Question: Looking at the figure, what chart type is it?
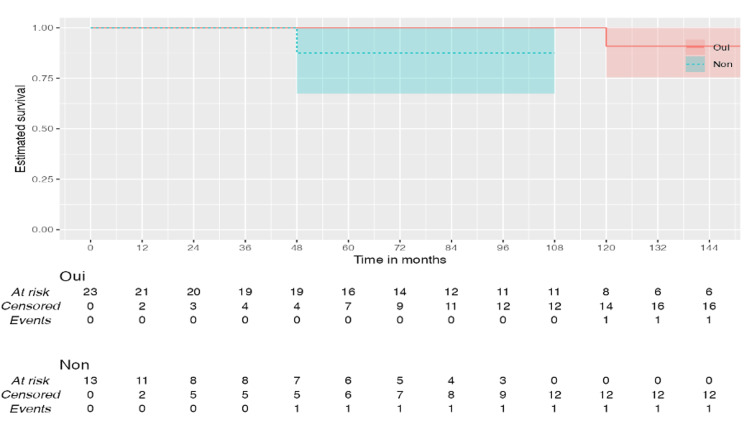
Answer: survival